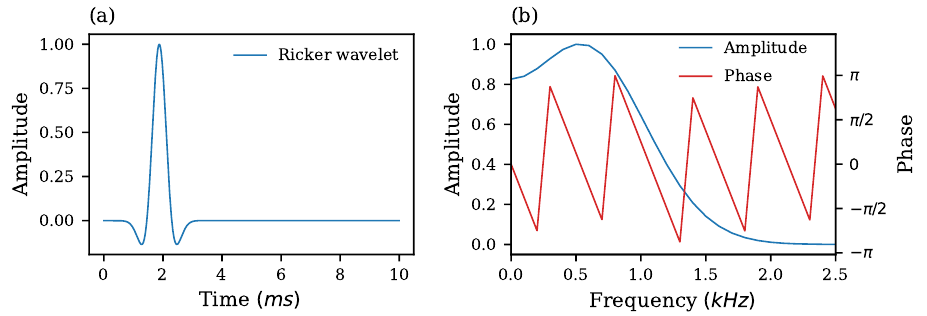
Figure 10. Ricker wavelet of unit amplitude with center frequency 0.8 kHz used as velocity source for the excitation in forward seismic simulation model: ( a ) normalized amplitude in time domain, ( b ) normalized amplitudes in frequency